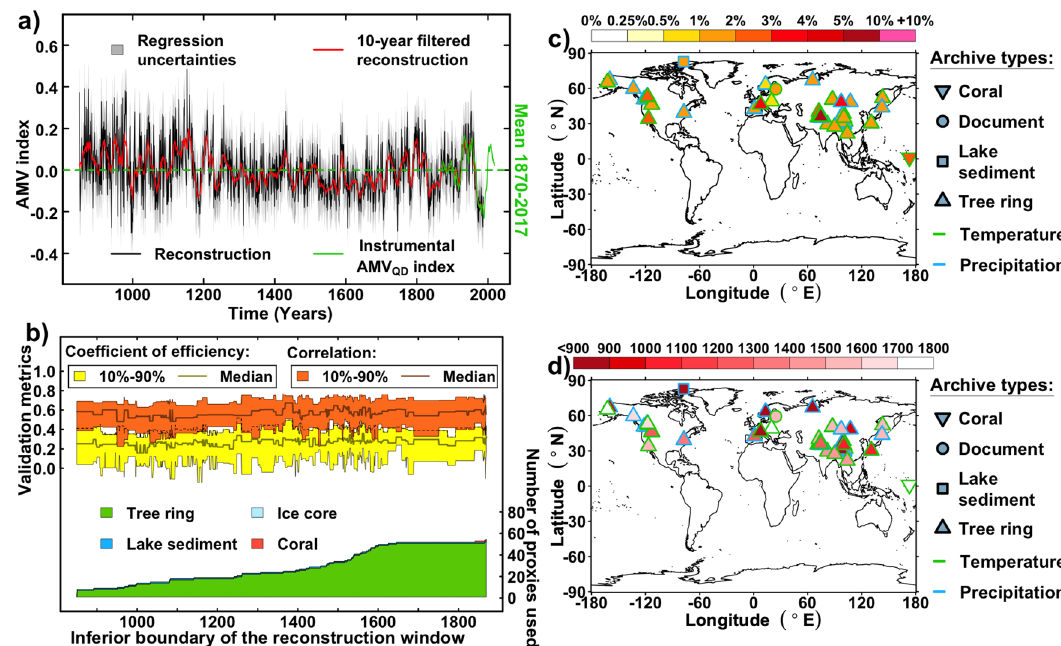
Fig. 2 | Nested reconstruction of the Atlantic Multidecadal Variability (AMV) and related proxies. a Black line: Annually resolved nested reconstruction of the AMV F index using random forest 52 (see “ Methods ” ). Red line: 10-years kernel smoothed nested reconstruction, black line: annually resolved nested reconstruc- tion. The regression uncertainties of the annually resolved nested reconstruction (black line) are de fi ned for each timestep of the nested reconstruction as ±2 stan- dard error of the regression. Green line is the time series of the instrumental